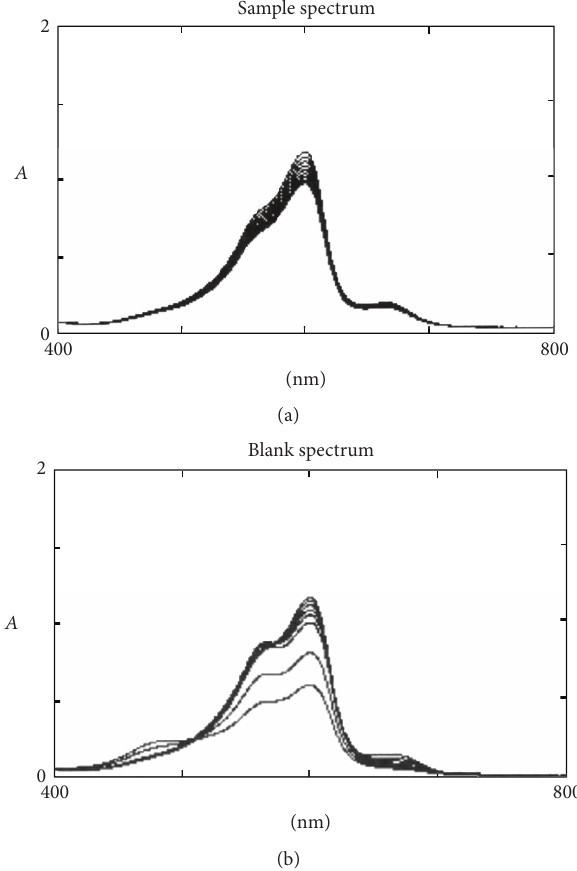
F 1: Absorption spectra of (a) inhibited and (b) unin- hibited reactions. Conditions: sulfuric acid,